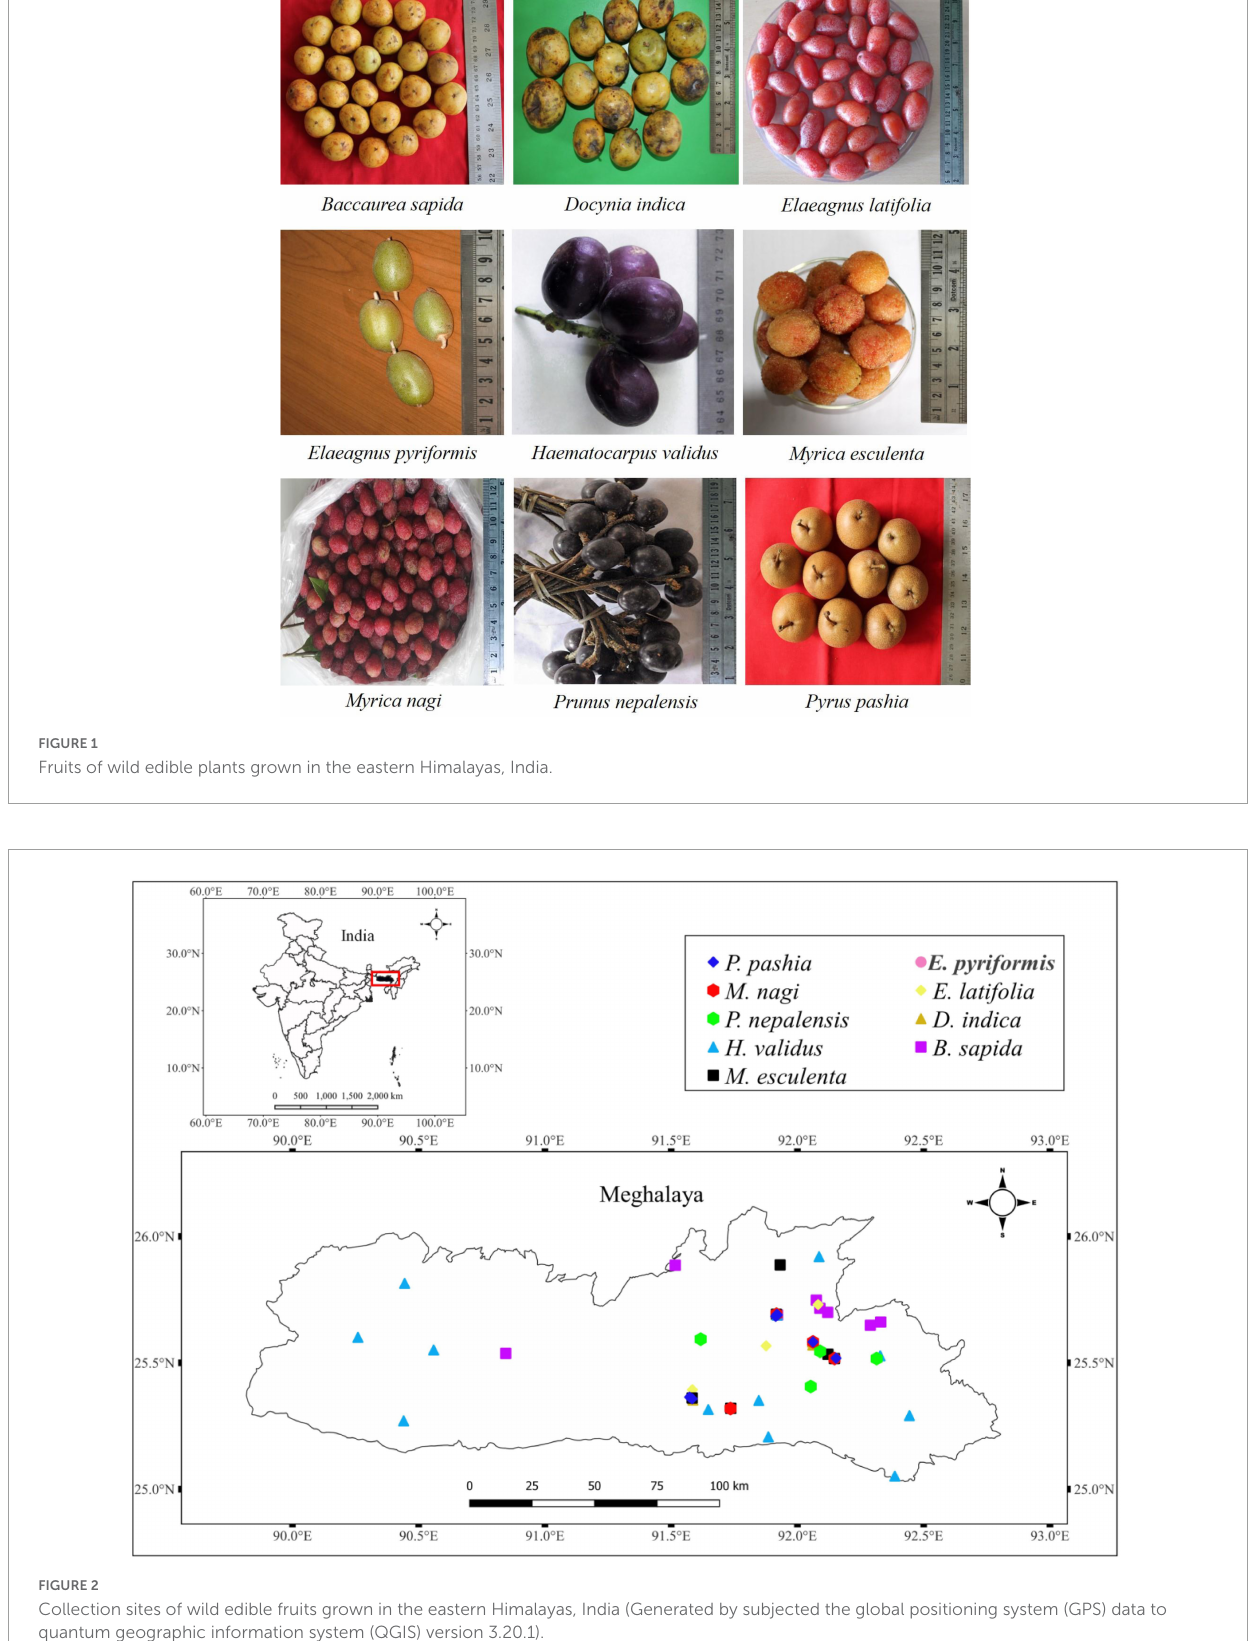
Frontiers in Nutrition